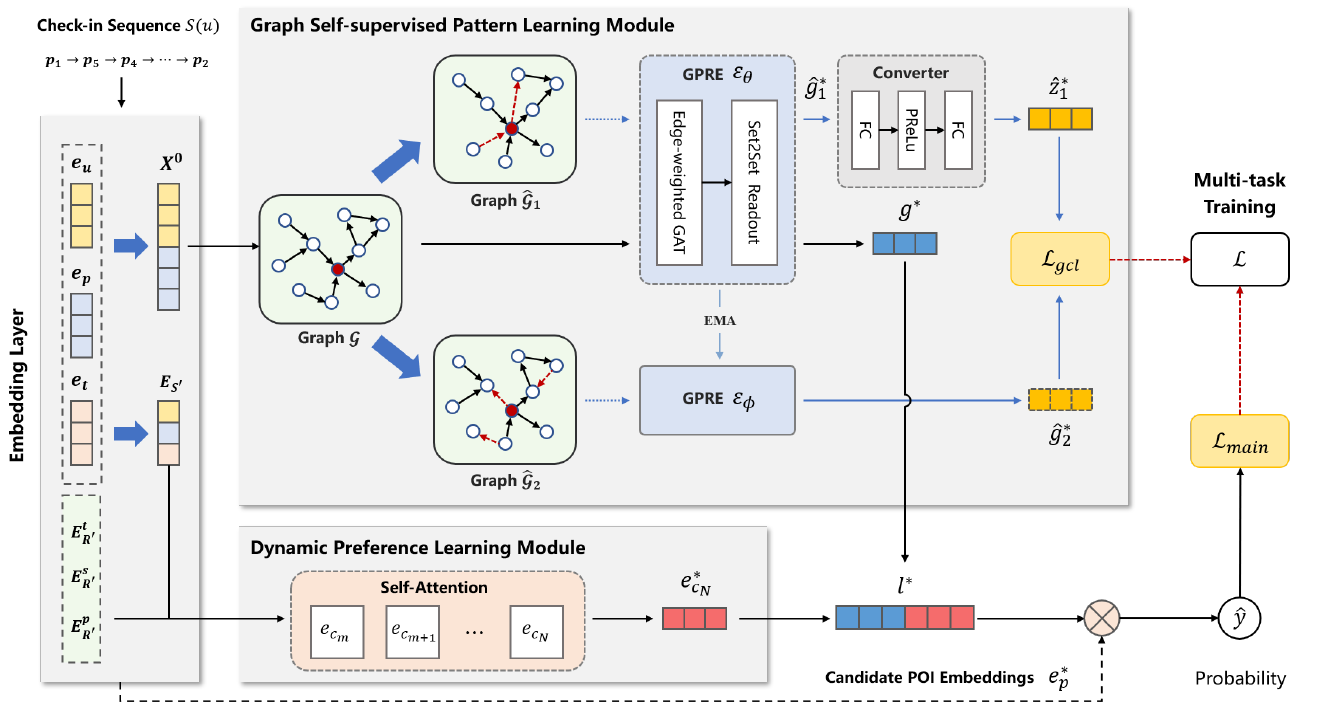
Figure 2. Our proposed GSBPL